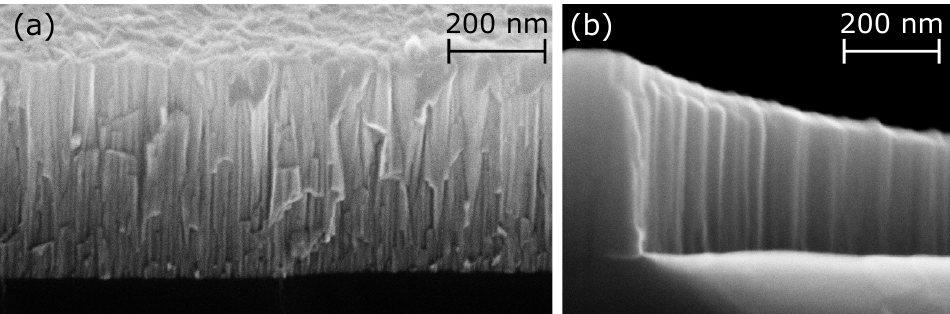
Figure 3. Cross-sectional SEM images of samples produced using an N 2 /Ar ratio of ( a ) 27% and ( b ) 50%. A magnetron power of 600 W and a processing pressure of 0.2 Pa are kept